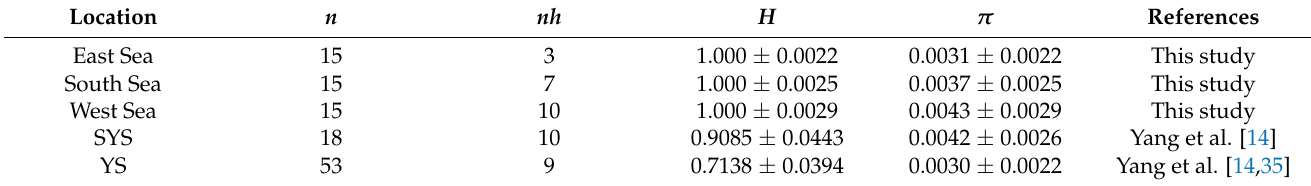
Table 1. Indicators of molecular genetic diversity for the mitochondrial control area of N. phocaenoides in Korea.